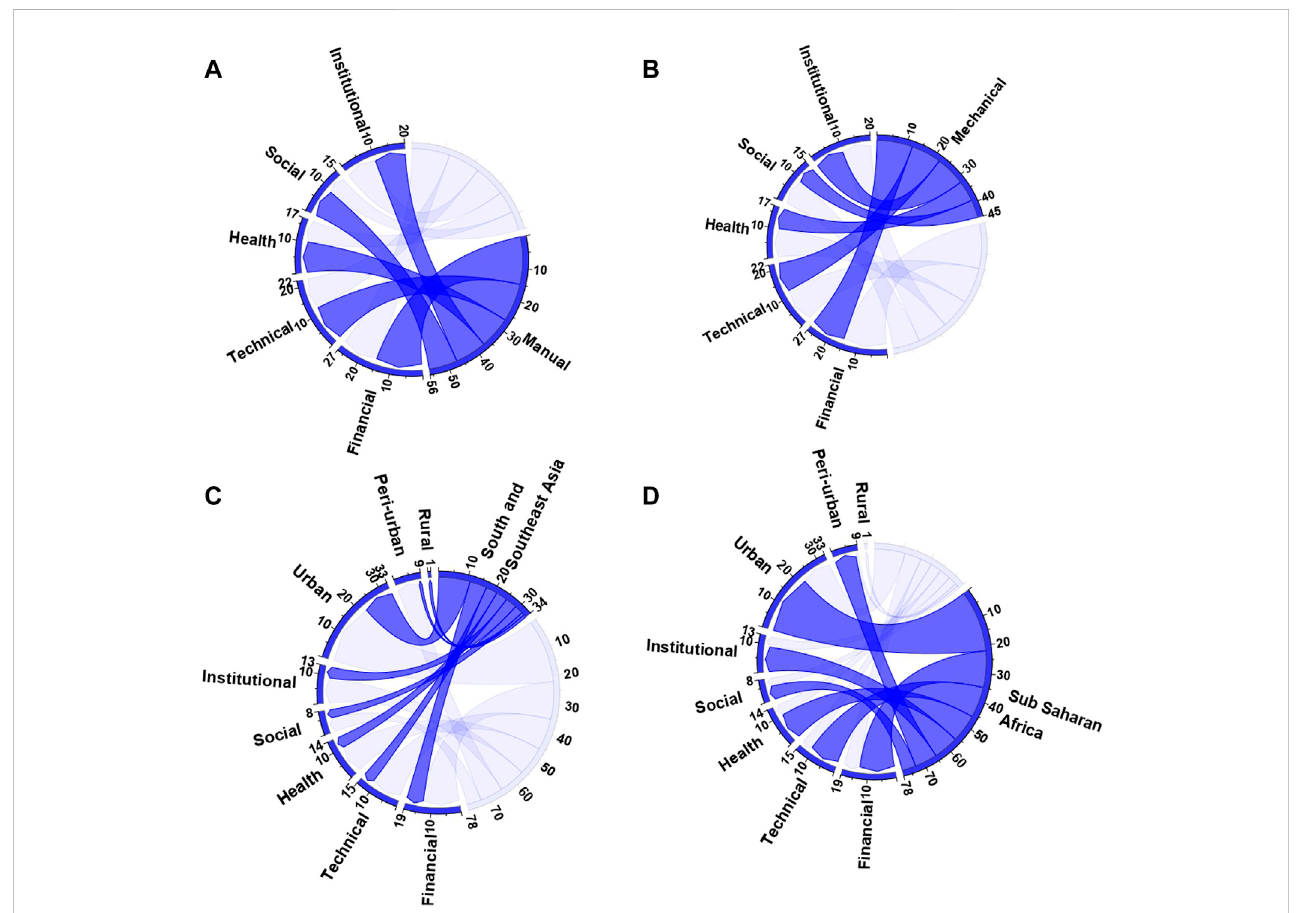
FIGURE 5 Challenges faced by feacal sludge emptiers (A) Manual emptying method (B) Mechanical emptying method (C) Sub-Saharan Africa (D) South and Southeast Asia.